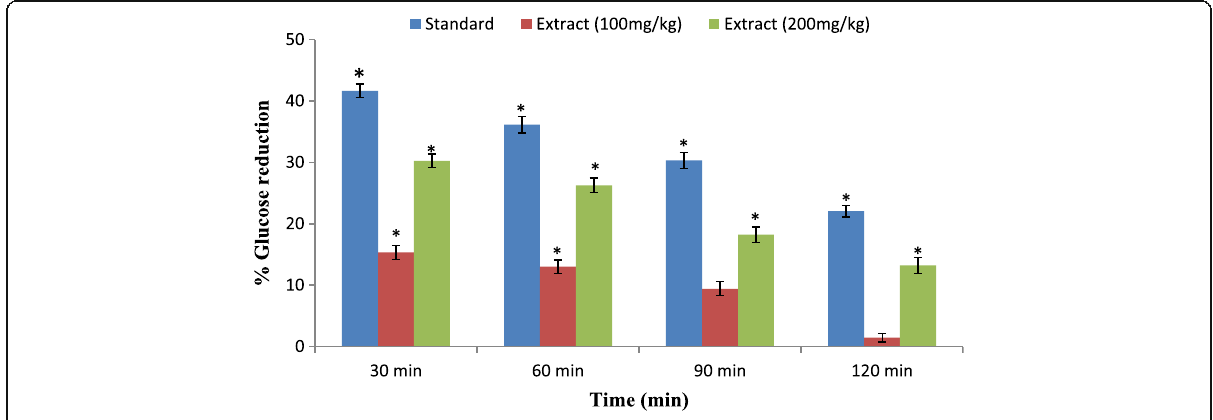
Fig. 4 Percent reduction of blood sugar content by the different doses of